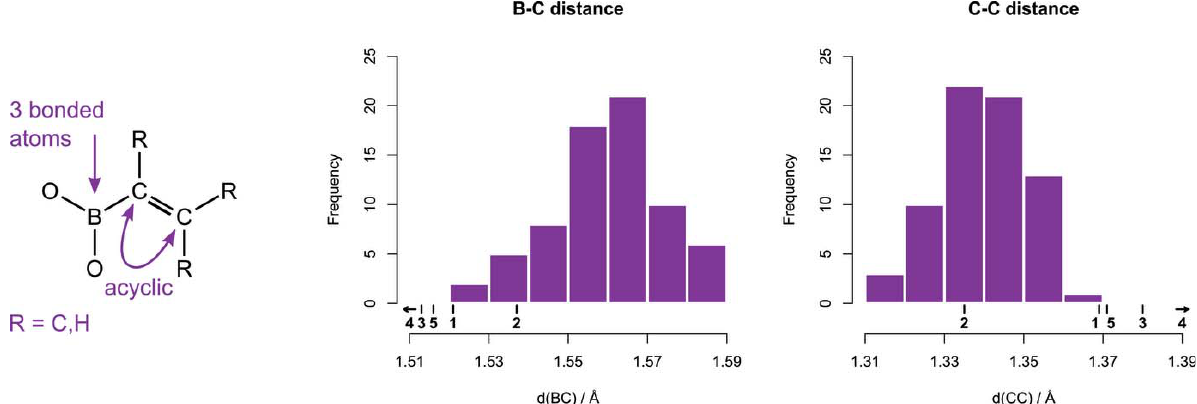
Figure 3 Statistical analysis of B—C and C—C bond lengths in vinyl boronates. The query substructure and restrictions are shown on the left. Problematic or irrelevant structures were removed. The bond distances of reference compounds are (Table 1, Fig. 2). C—N bond lengths are 1.341 A ˚ ( 4 ), 1.350 A ˚